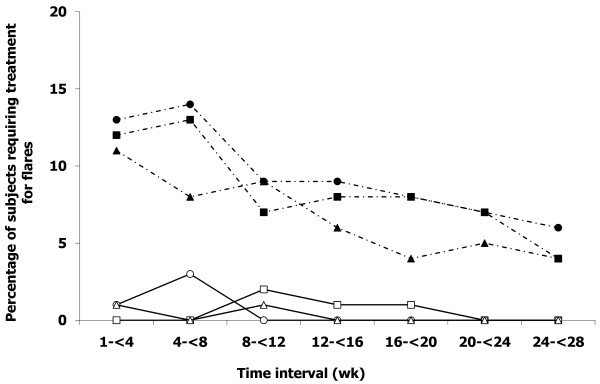
Proportion of subjects requiring gout flare treatment. Solid lines, open symbols, prior participation in long-term open-label ULT extension trials [13,14]. Dashed lines and closed symbols, no prior participation in long-term open-label ULT extension trials; squares, febuxostat 40 mg daily; circles, febuxostat 80 mg daily; triangles, allopurinol 200/300 mg daily.